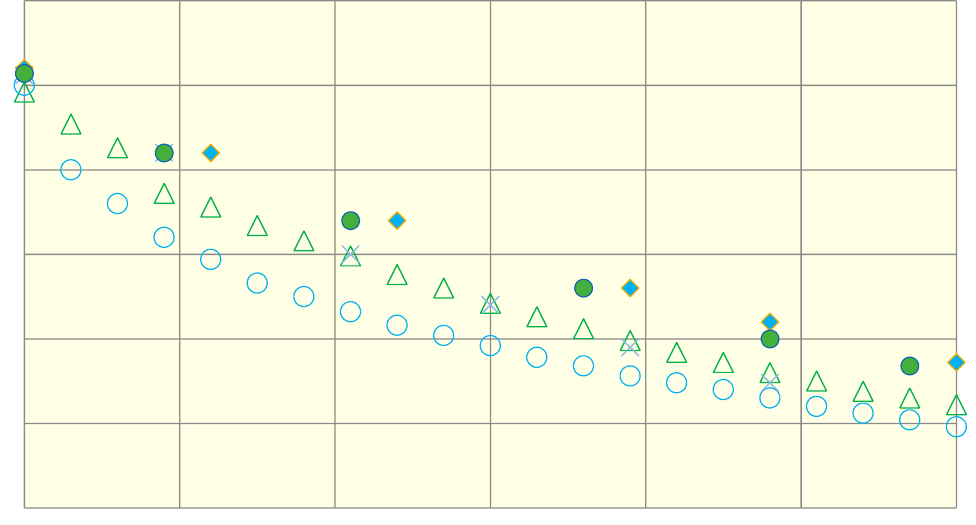
Figure 9. The cooling rate of the samples of minced fish in air thermostat: ○ —1 (dose 0 к Gy); ♦ —2 (dose 1 к Gy) ; ● —3 (dose 2 к Gy); ∆ —4 (dose 3 к Gy) ; ×—5 (dose 4 к Gy).